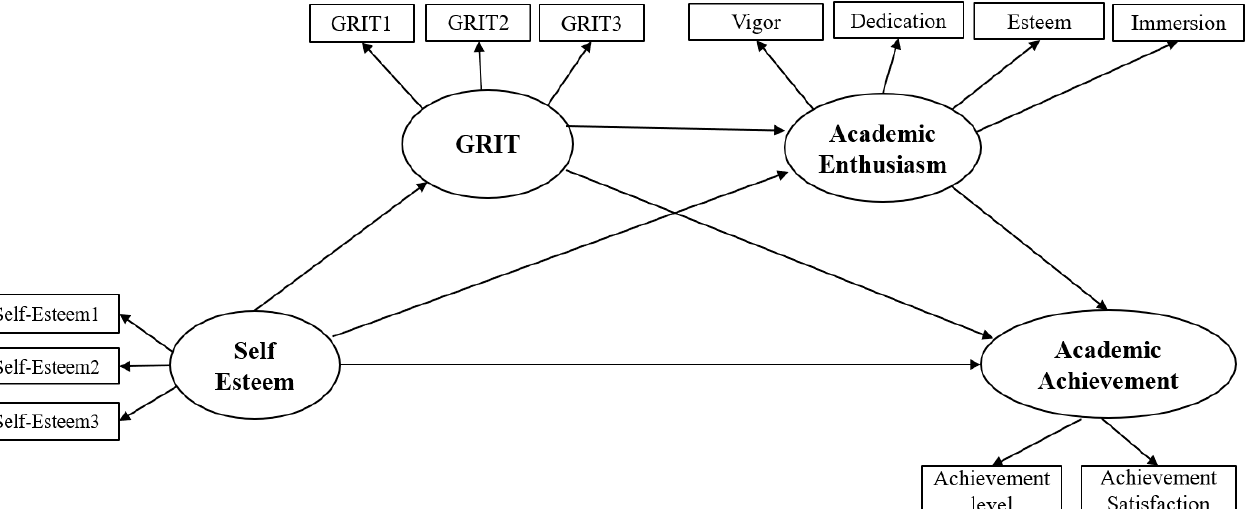
Figure 4. Full mediation model. In order to analyze the relationship between major variables in this study, Standard ‐ ized Path Estimates ( β ), Standard Error (S.E), t ‐ value (C.R), and p ‐ value were reviewed in the full mediation model. The results of analysis are shown as follows in Table 4 and Fig ‐ ure 4. The influence of self ‐ esteem on GRIT turned out positive with β = 0.784 ( p < 0.001). The influence of GRIT on academic enthusiasm was significant with β = 0 .676 ( p < 0.001). In addition, the influence of academic enthusiasm on academic achievement turned out to be significant with β = 0.633 ( p < 0.001). On the other hand, the relationship between GRIT and academic achievement showed a negative relationship with β = − 0.082 ( p = 0.031), and the relationship between self ‐ esteem and academic enthusiasm turned out to be of significance ( p = 0.676).